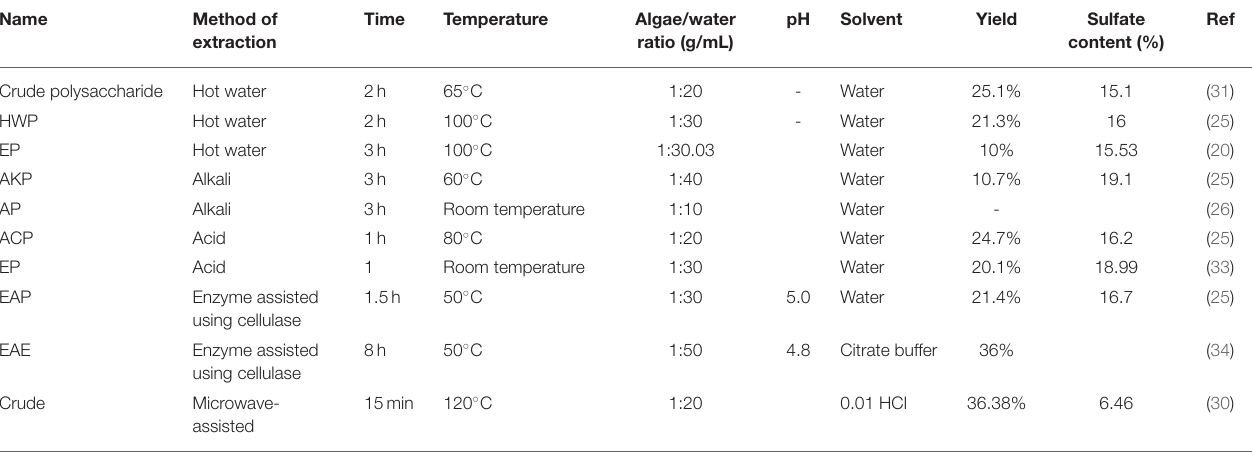
TABLE 1 | Summary of the extraction methods and conditions for the isolation of polysaccharides from Enteromorpha prolifera